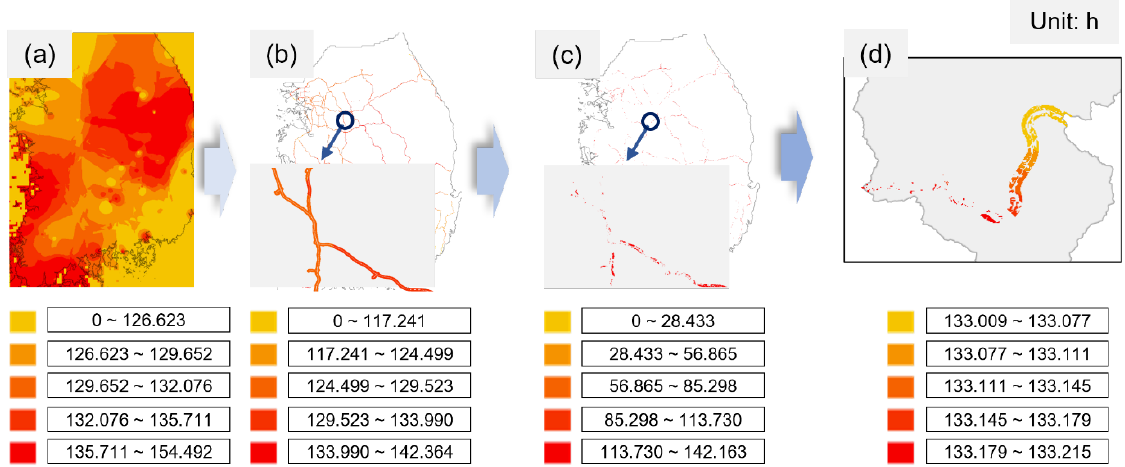
Figure 7. Maps of ( a ) solar PV power output per capacity per hour; ( b ) extracted PV power map in the vicinity of the highway networks (200 m); ( c ) restricted PV power map by geo-spatial analysis; and ( d ) visualization of the PV power map in the case area (Ucheon-myeon).